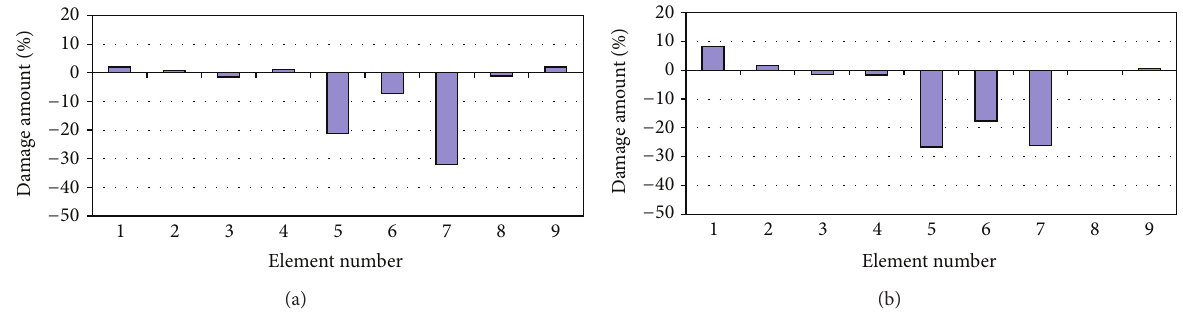
Figure 9: Inverse damage predictions for 𝐹 2 = 20 kN, (a) 5 experimental frequencies for damaged structure used, and (b) 8 experimental frequencies for damaged structure used.